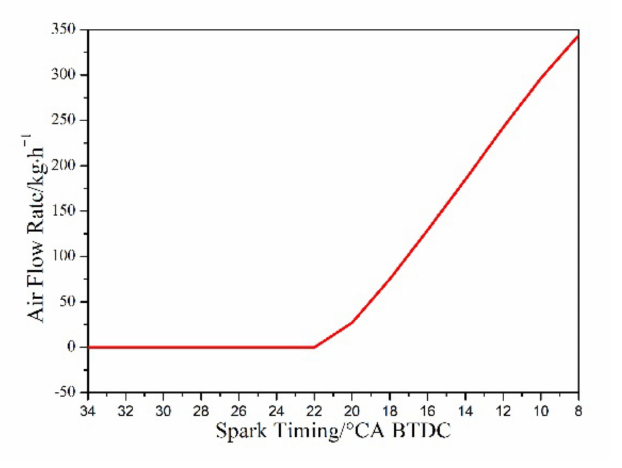
Figure 14. Drainage tube